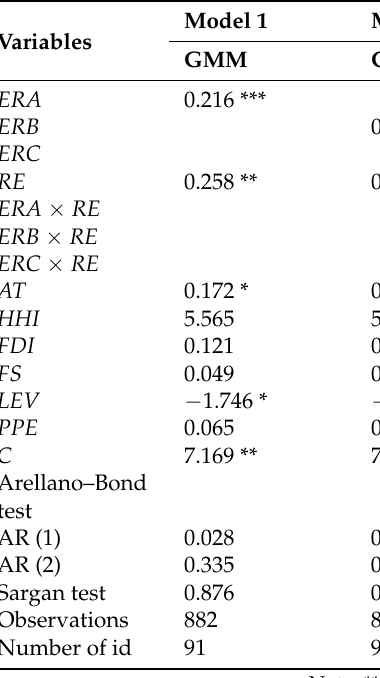
Table 7. Robustness